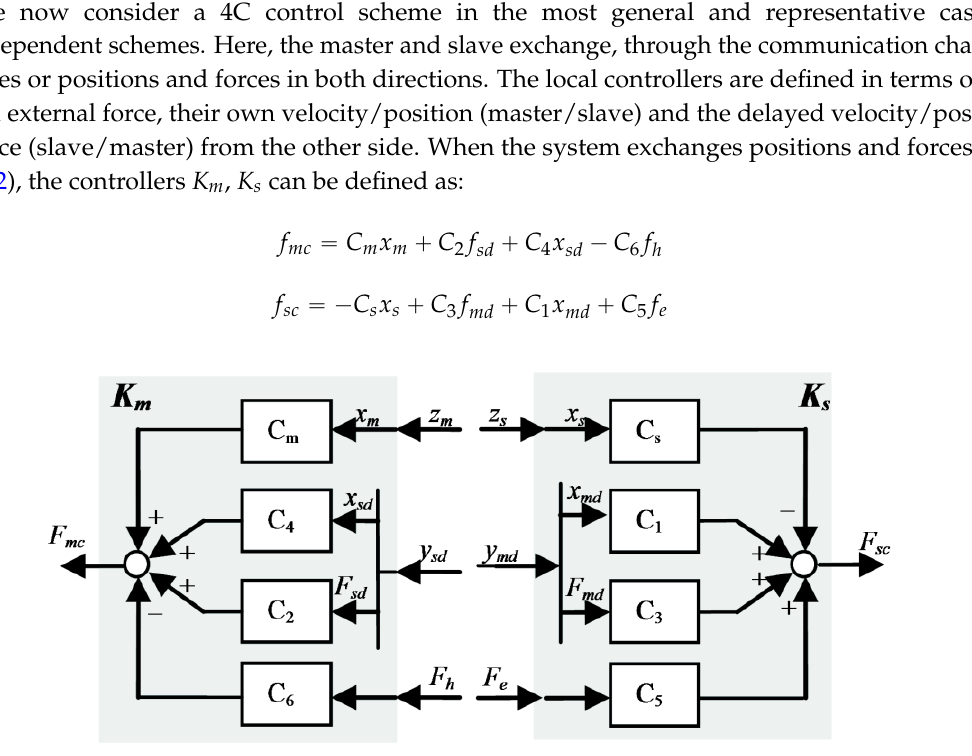
Figure 2. Local controllers in the 4C control scheme.